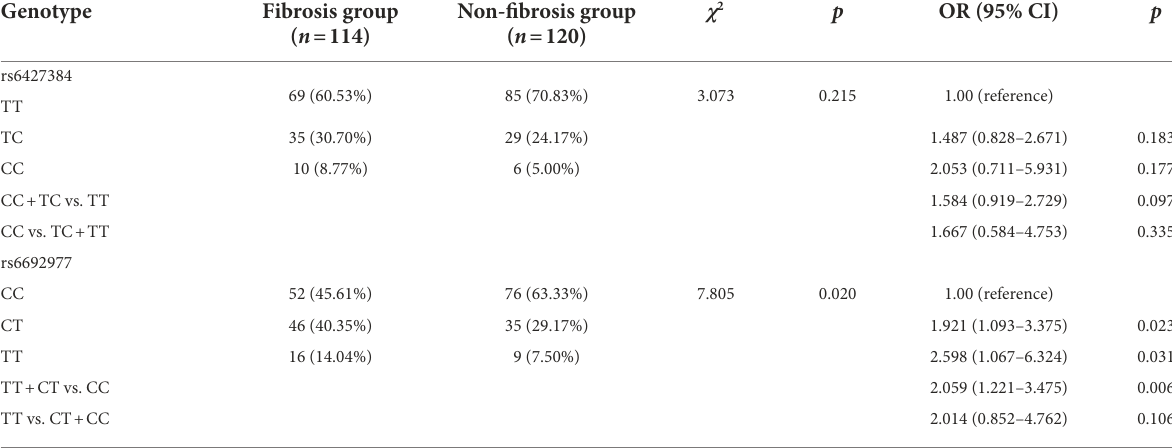
TABLE 2 Comparison of genotype distribution and genetic models of FCRL5 gene SNPs between fibrosis and non-fibrosis group. Genotype